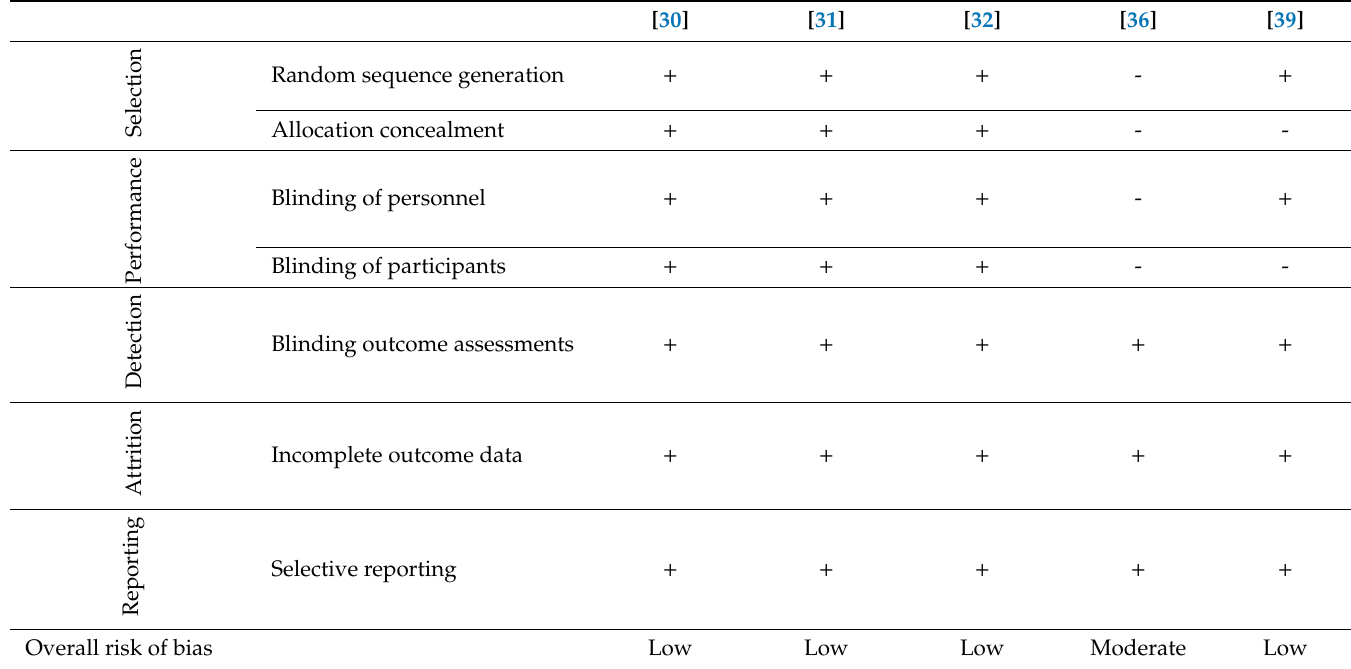
Table 4. Risk of bias assessment for clinical reports on the cardioprotective e ff ect of